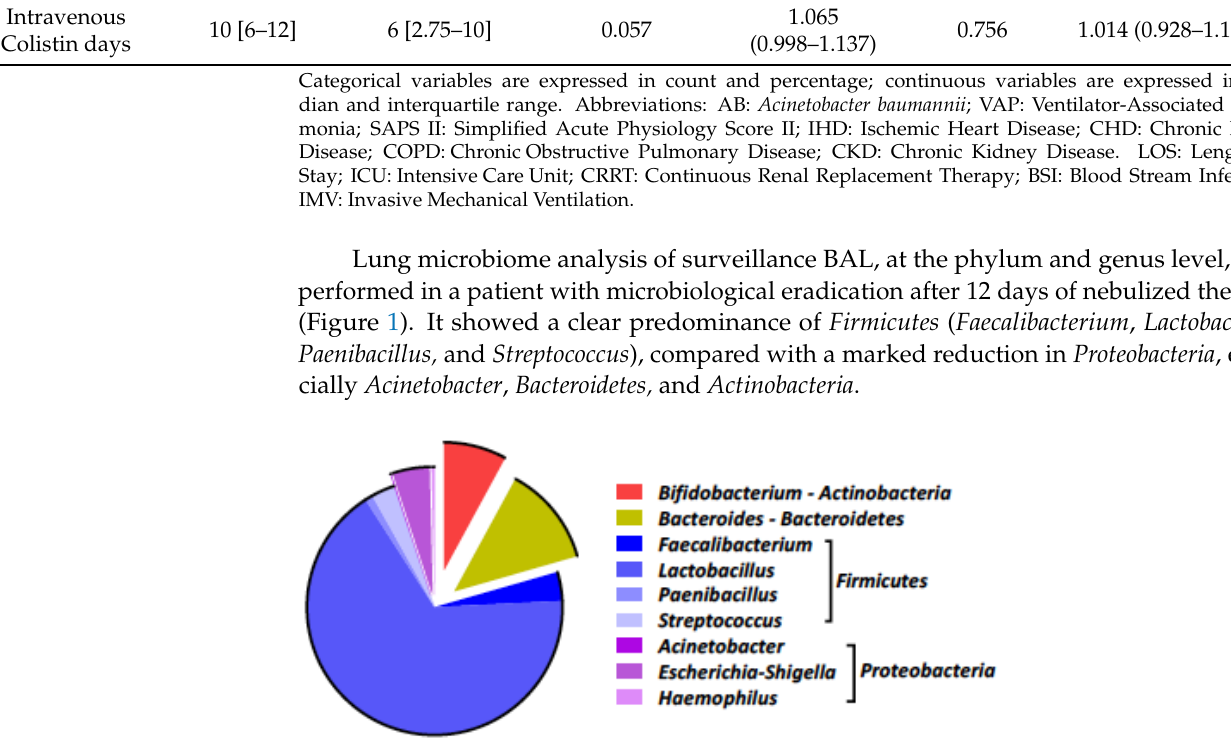
Figure 1. Lung microbiome composition of a representative patient with microbiological eradica- tion. Table 2. Univariate and multivariate analysis of factors associated with AB microbiological eradi- cation.